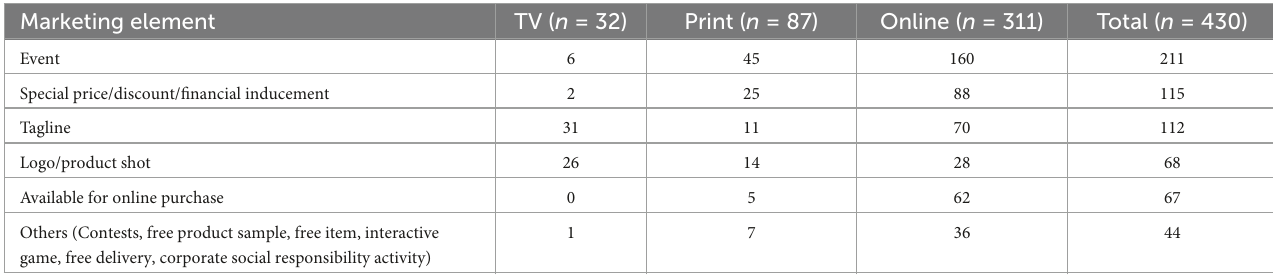
TABLE 3 The number of used marketing elements in unique materials across multimedia platforms monitored.